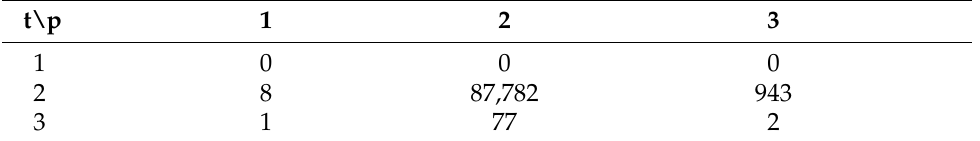
Table 11. The confusion matrix of the TUG for participant 16. The participant scores 2 and 3, but not 1. The most values are in class 2. Due to the imbalance the accuracy is high, but the performance is low. t = true label, p = predicted label.